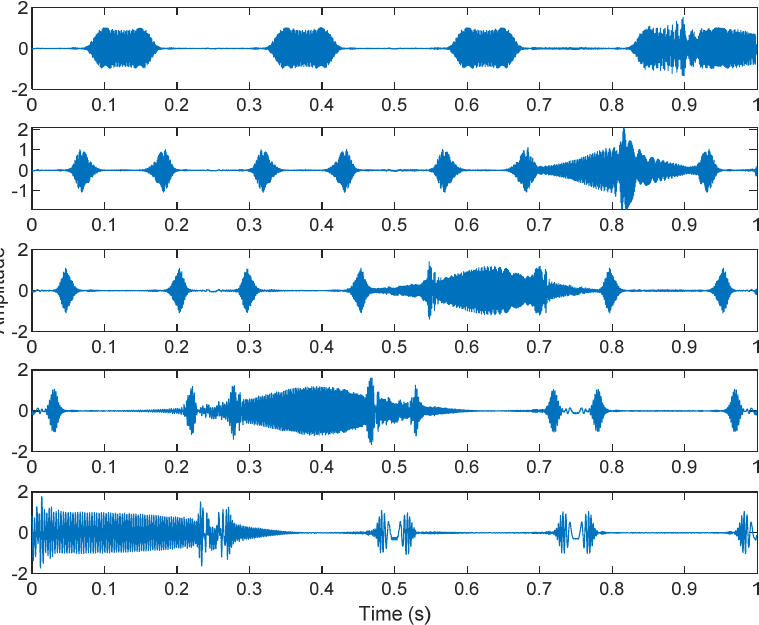
Figure 16. Analysis of data separated by ICA-VMD.